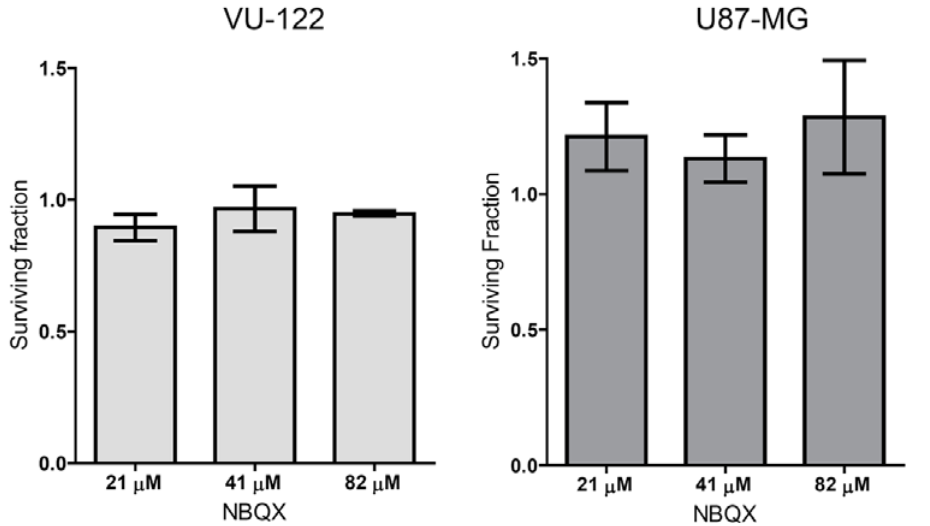
Figure 4. Effect of AMPA receptor antagonist NBQX on proliferation of GBM cell lines. Surviving cells fractions after exposure of GBM cells to different concentrations of the AMPA receptor antagonists NBQX. Shown are the averages of three experiments performed in triplicate. Error bars indicate the standard deviation. Corresponding GluR mRNA subunit expression levels are indicated on the left.